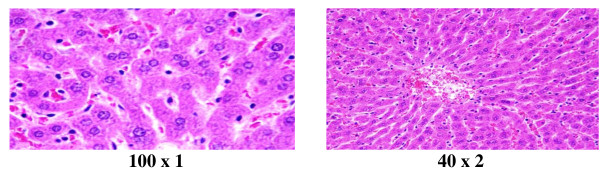
GNPs-treated rat received 100 μl of 20 nm particles for 7 days